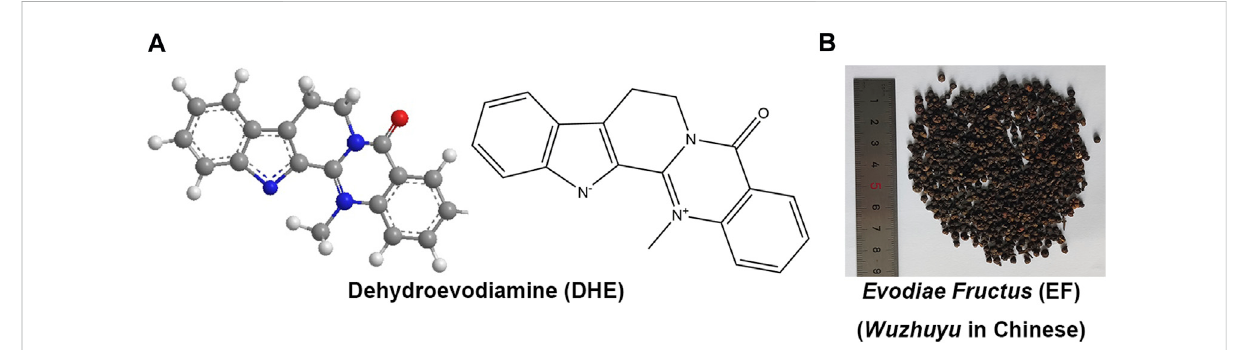
FIGURE 1 The chemical structures of DHE (PubChem CID: 9817839) (A) and the prepared slices of EF (B) . Notes: DHE, dehydroevodiamine; EF, Evodiae Fructus